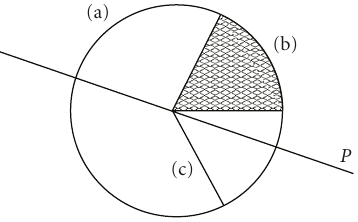
Figure 8: Illustration of the situation in the proof of Lemma 1. (a) represents the hypersphere in R 1 × 2( l +1) M with radius 1 and center at the origin. The shaded sector of (b) represents the part of the cone in R 1 × 2( l +1) M with vertex at the origin that is lying inside the hypersphere with respect to the receiver inner product. (c) represents the i th receiver that lies outside the cone in (b). P represents the hyperplane that lies between the cone and the i th receiver, passing through the origin, chosen such that the reflection of the i receiver using the receiver inner product about the hyperplane P lies inside the